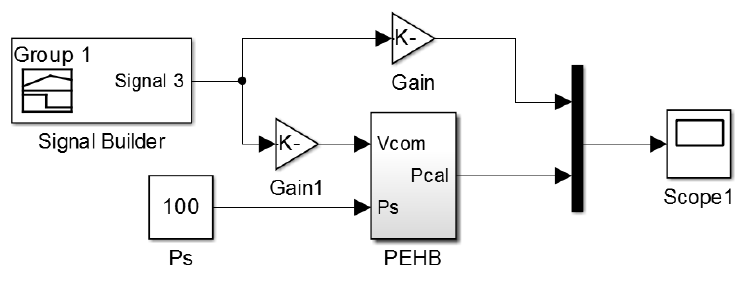
Figure 12. Block diagram of a single ‐ wheel PEHB system input and output. Figure 12. Block diagram of a single-wheel PEHB system input and output. Figure 12. Block diagram of a single-wheel PEHB system input and output. Figure 12. Block diagram of a single-wheel PEHB system input and output.